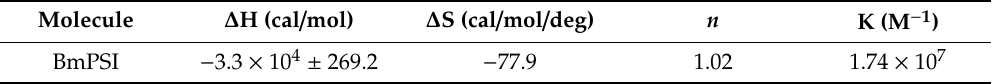
Table 1. The energetic profile of the interaction of the BmPSI with CE1 obtained from ITC. Molecule